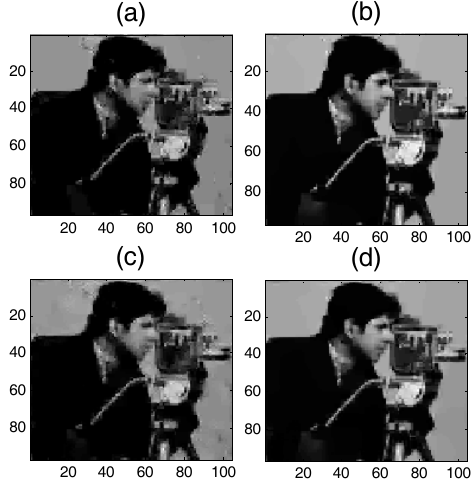
Figure 8. The recovery effects of the proposed SAITA- L p ( p ∈ { 1/2, 2/3 } ) and the conventional L p ( p ∈ { 1/2, 2/3 } ) algorithms for the M / N = 0.2 and mSNR = 40 dB cameraman image. ( a ) L 1/2 , RSNR = 15.7316 dB; ( b ) SAITA- L p algorithm ( p = 1/2), RSNR = 20.5714 dB; ( c ) L 2/3 , RSNR = 16.3098 dB; and ( d ) SAITA- L p algorithm ( p = 2/3), RSNR = 20.1259 dB.